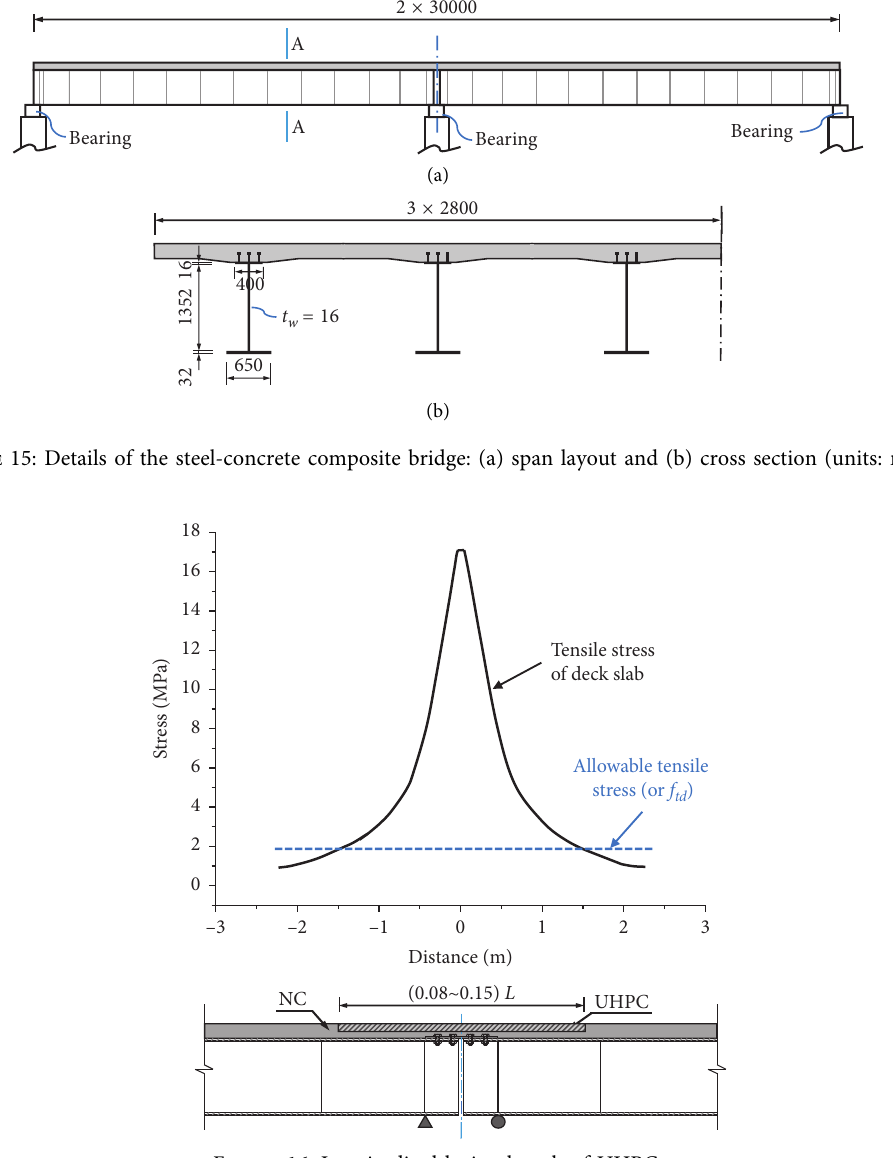
Figure 16: Longitudinal laying length of UHPC.